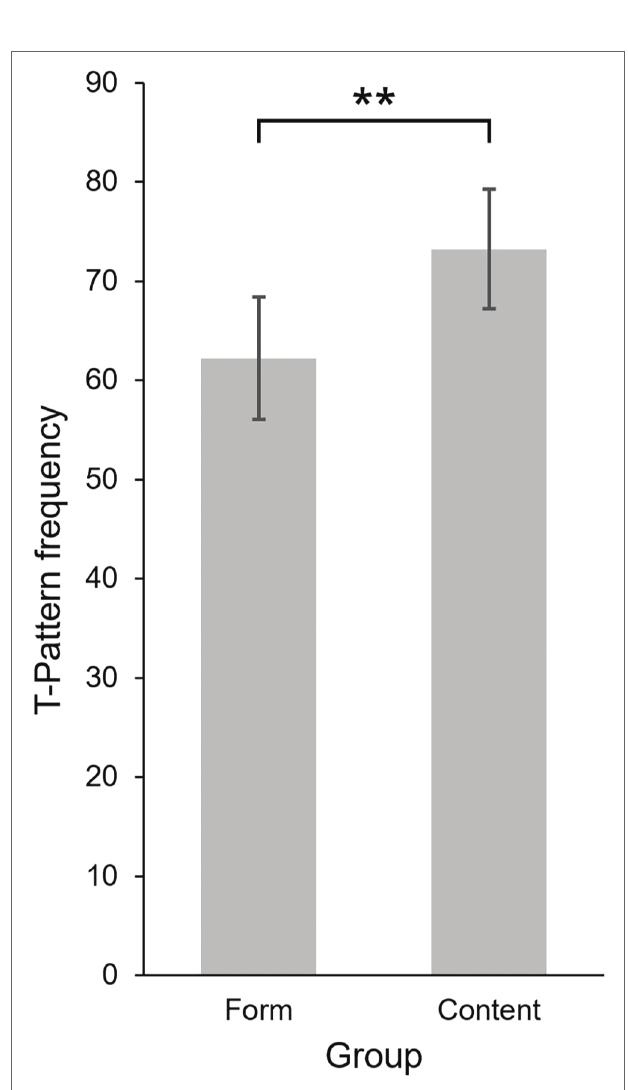
FIGURE 4 | Mean frequencies of T-patterns with blinks and events of cinematic structure in the form condition and content condition. Error bars indicate 95% CIs of the SEM. ** p <